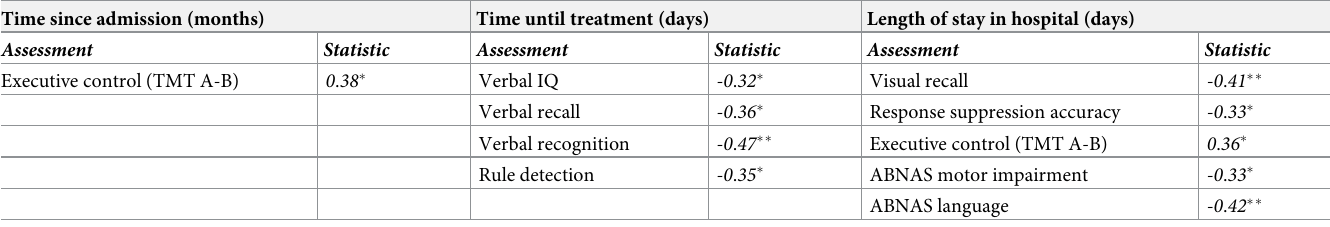
Only significant correlations as assessed by Spearman rho test are shown. All patients were combined to increase the sample size. Notations � p � 0.05